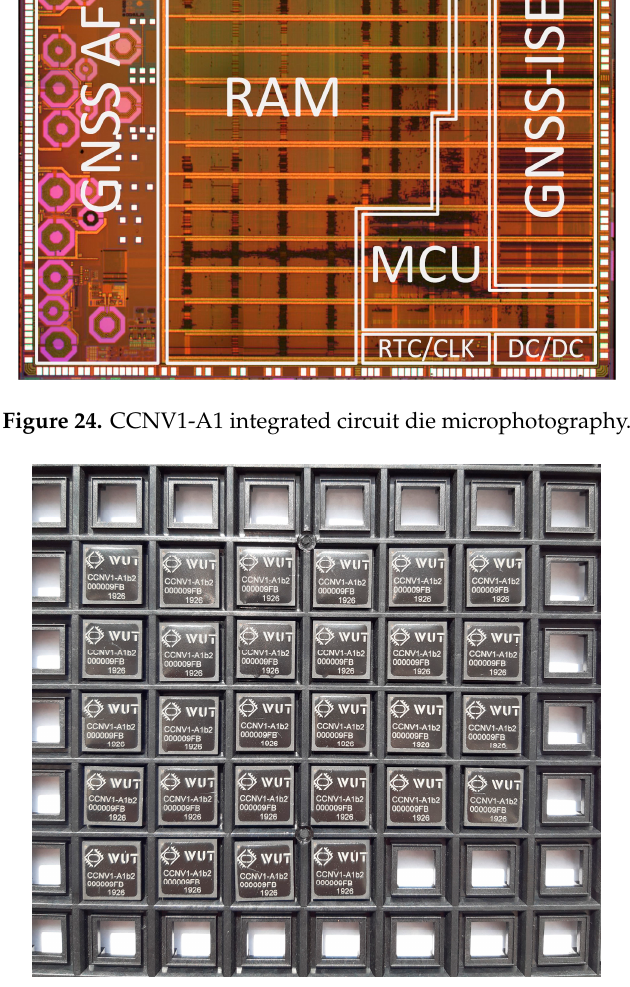
Figure 25. CCNV1-A1 packaged dies.